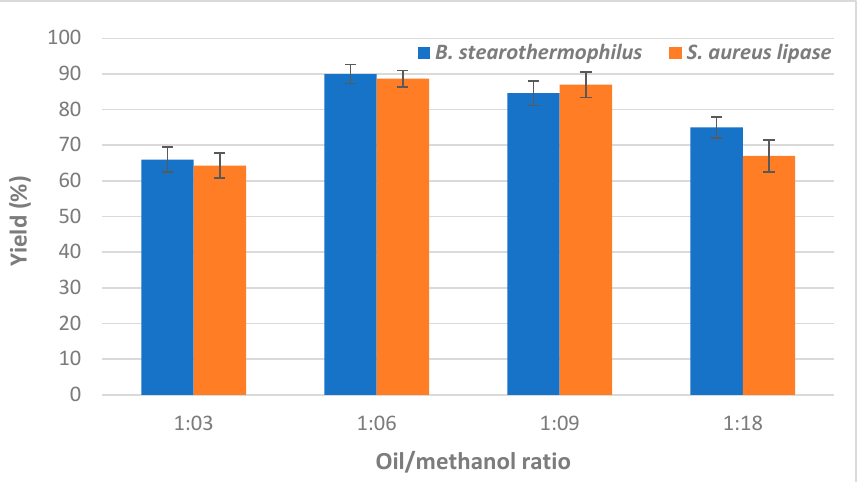
Figure 1. Effect of oil to methanol molar ratio on CaCO 3 -immobilized-lipase catalyzed transesterifi- cation of waste cooking oil (WCO) for biodiesel synthesis. Experimental conditions were: reaction temperature 45 °C, reaction time 24 h, water content 5%, lipase loading 1%, agitation speed 150 rpm. Experiments were performed in triplicate and error bars indicate mean ± standard deviation.